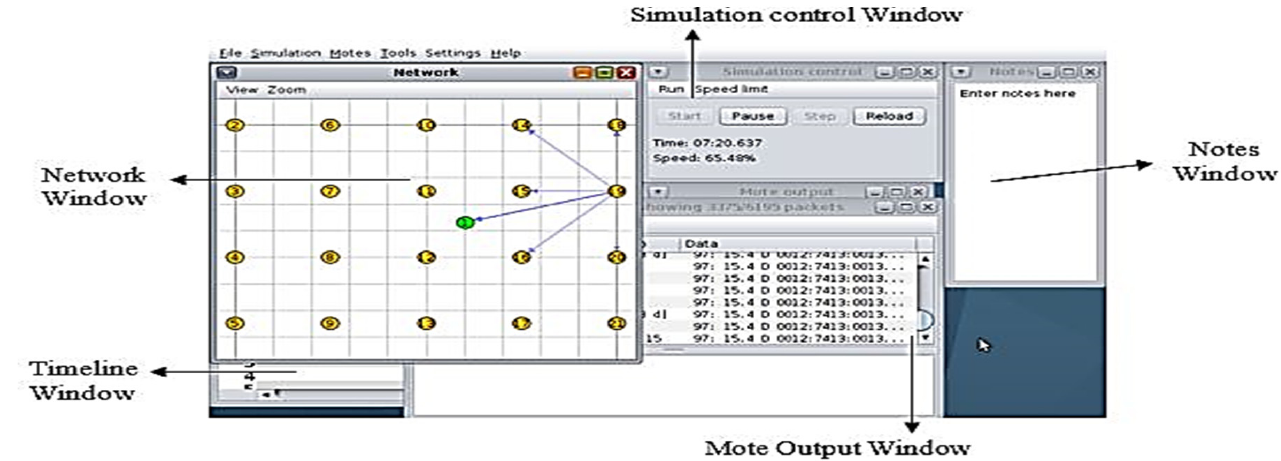
Figure 3. Cooja’s window.